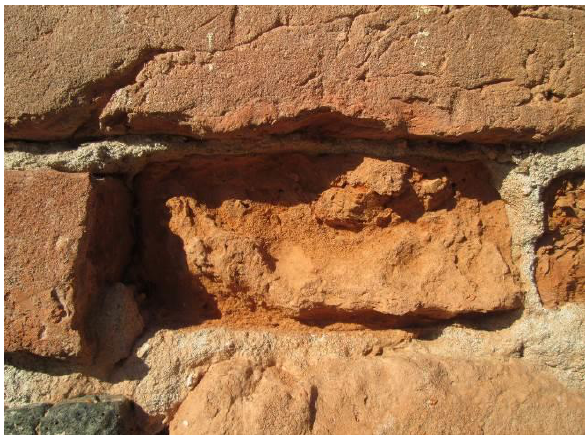
Figure 6: Powdering of the bricks.